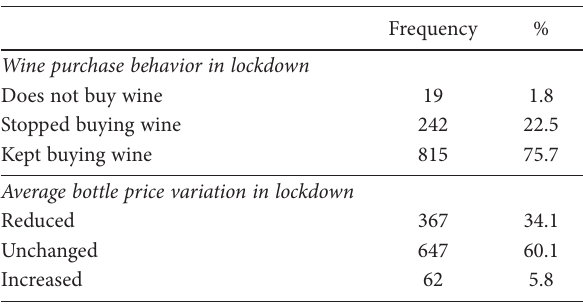
Table 2. Changes in wine purchase pattern following the